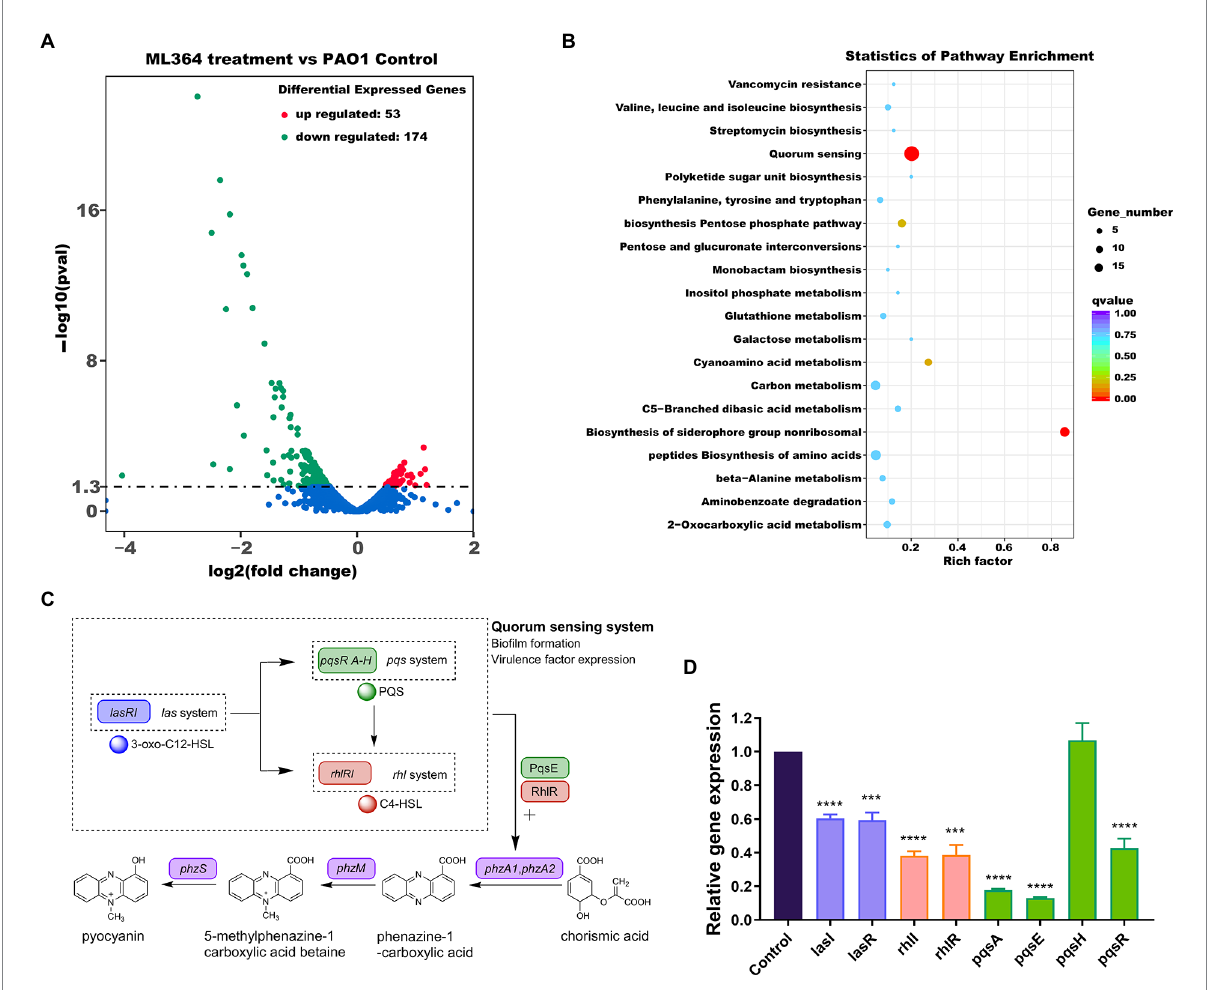
FIGURE 2 ML364 treatment attenuated virulence factor production by interfering with quorum sensing systems. Pseudomonas aeruginosa PAO1 was cultured for 6 h with or without 256 μ g/ml ML364. (A) Volcano plots of differentially expressed genes in P. aeruginosa PAO1 treated with ML364. (B) KEGG enrichment analysis of differentially expressed genes in P. aeruginosa PAO1 treated with ML364. (C) Schematic diagram of the P. aeruginosa quorum-sensing hierarchy and biosynthesis system of pyocyanin. (D) Transcription levels of quorum sensing-related genes in P. aeruginosa PAO1 with ML364 treatment determined by real-time PCR. Data were analyzed via the Student’s t -test, compared to those of the PAO1 control group; * p < 0.05, ** p < 0.01, *** p < 0.001, **** p <